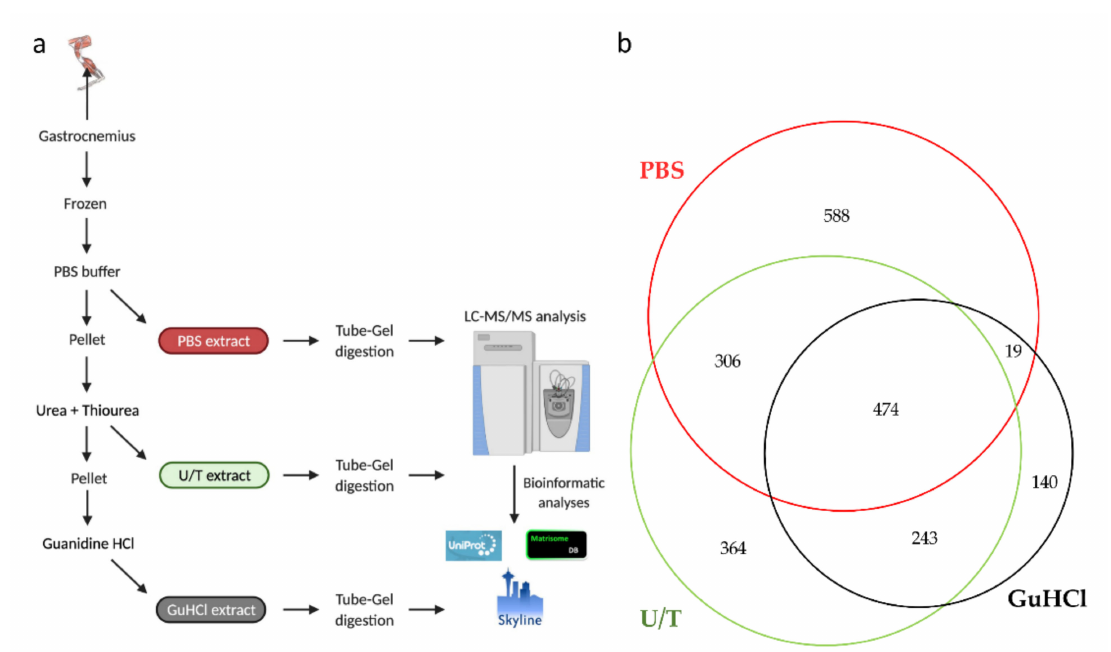
Figure 1. ( a ) Sequential protein extraction from gastrocnemius muscle. ( b ) The Venn diagram shows the number of proteins identified in each